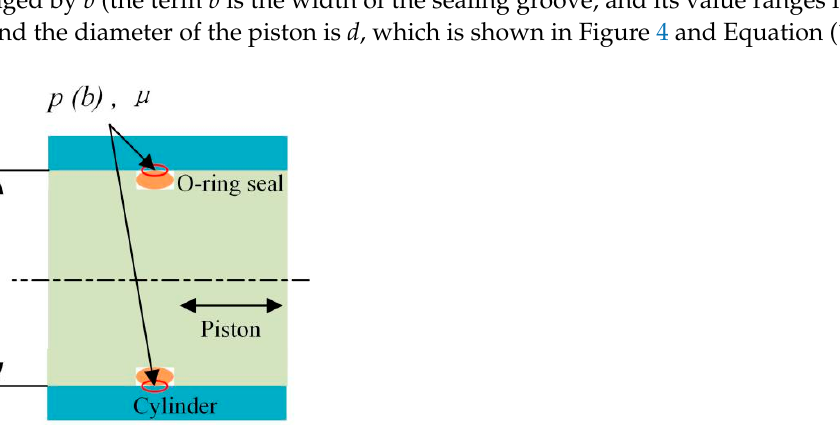
( c ) Figure 3. Schematic diagram of elastic sealing ring: ( a ) O-ring seal; ( b ) V-ring seal; ( c ) Y-ring seal .